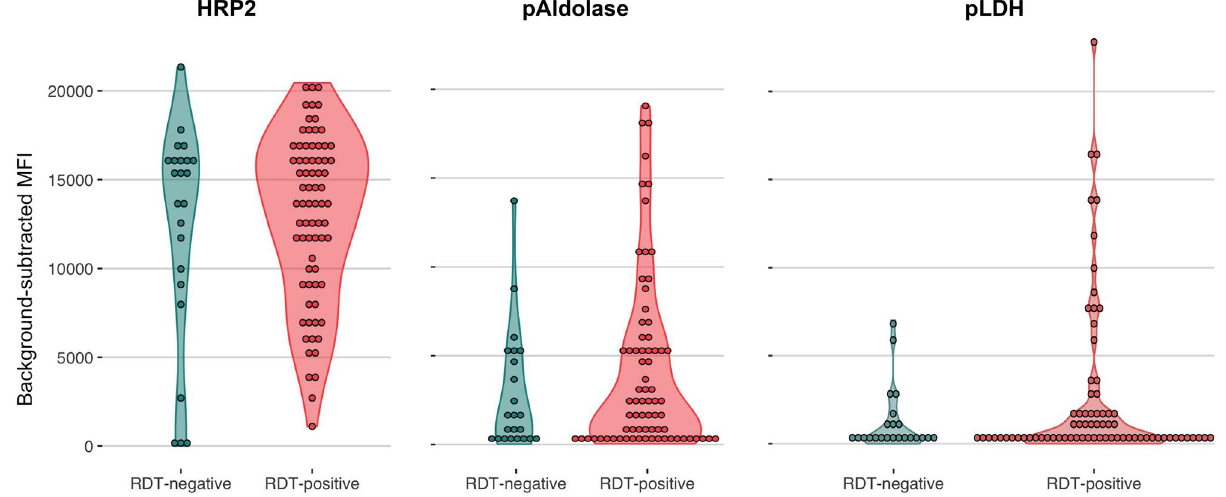
Figure 5. False-negative RDT results occurred in the setting of high HRP2 antigenemia. A Luminex bead- based immunoassay for three parasite antigens confirmed circulating HRP2 antigen in the majority of RDT- negative but PCR-positive/microscopy-positive isolates tested (RDT-negative). RDT-positive controls selected from the same facility are included for comparison. One pLDH value with background-subtracted MFI < 0 is not depicted. Log-transformed plots are provided in Supplementary Fig. 3. HRP2 P. falciparum histidine-rich protein 2, pAldolase Plasmodium aldolase, pLDH Plasmodium lactate dehydrogenase.